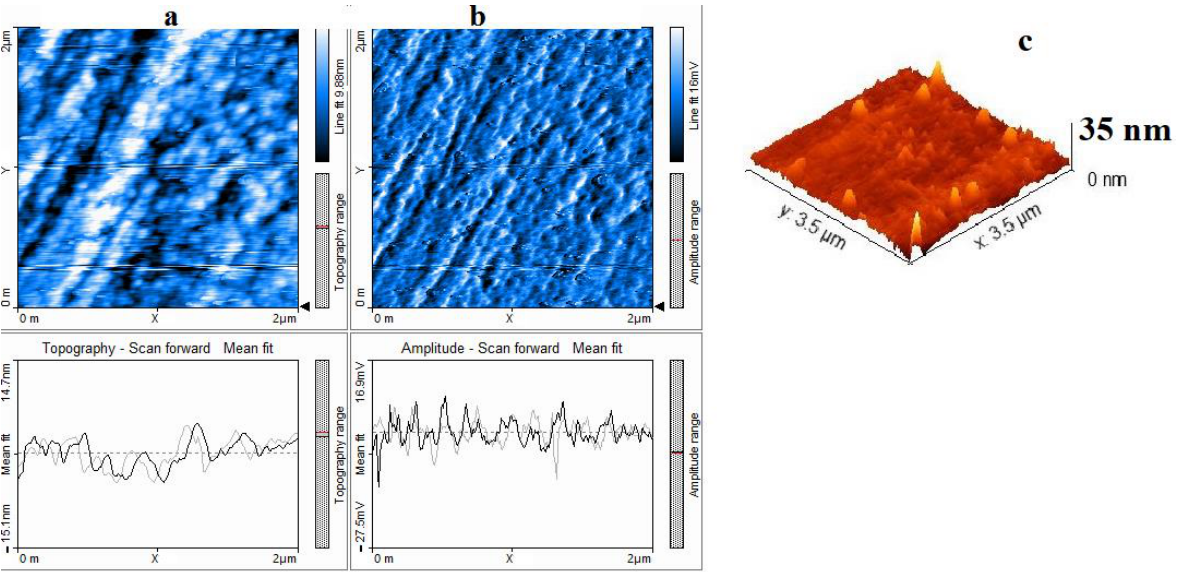
Figure 12. AFM image of a sample of the thermolysis product of silver maleate: ( a ) 2D-surface topography image, ( b ) 2D-amplitude image, ( c ) 3D-surface image.